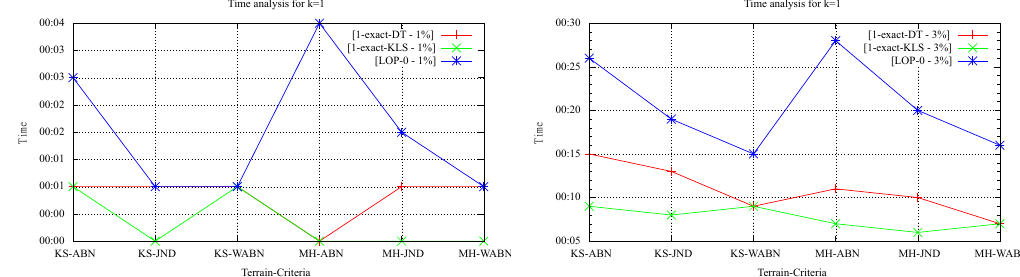
Figure 7. Running times of 1-exact-DT, 1-exact-KLS and LOP-0 for Kinzel Springs and Moorehead SE for 1% ( left ) and 3% ( right ) sample sets with k = 1 , for ABN, JND and WABN.